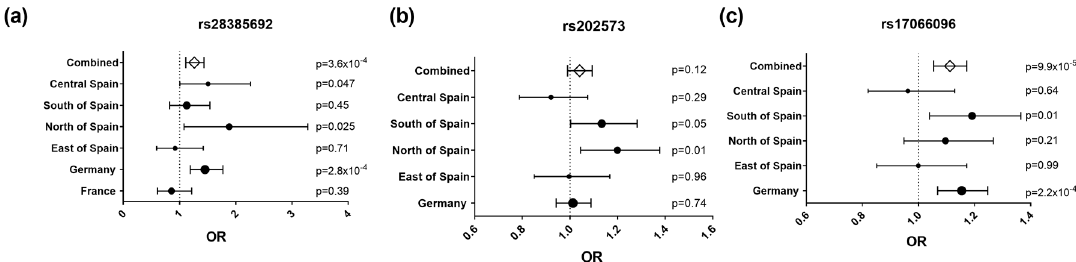
Figure 2. Forest plots representing effect size estimates (OR, 95% confidence interval) of the risk alleles of rs28385692 ( a ), rs202573 ( b ) and rs17066096 ( c ) in the study populations: Central Spain (Madrid area), South of Spain (Andalucía), North of Spain (Basque Country), East of Spain (Barcelona area), Germany, and France, and in the combined dataset. The dots’ size is proportional to the sample size of each population.